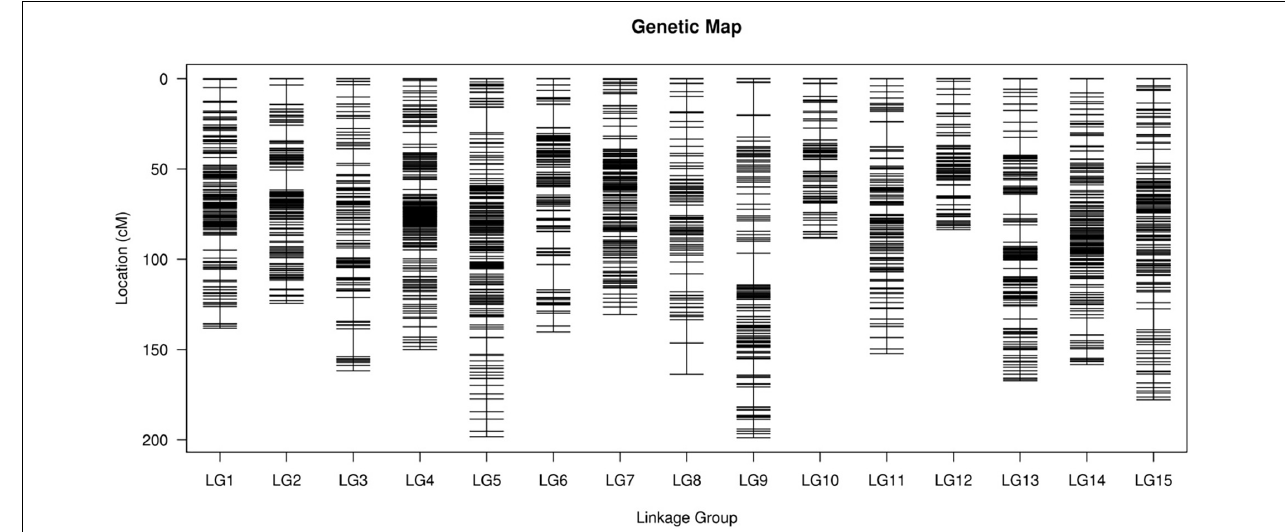
FIGURE 4 | The integrated high-density genetic map of sweet potato based on 3,178 SNPs. The x-axis and y-axis represent linkage groups and location, respectively. SNPs, single nucleotide polymorphisms.